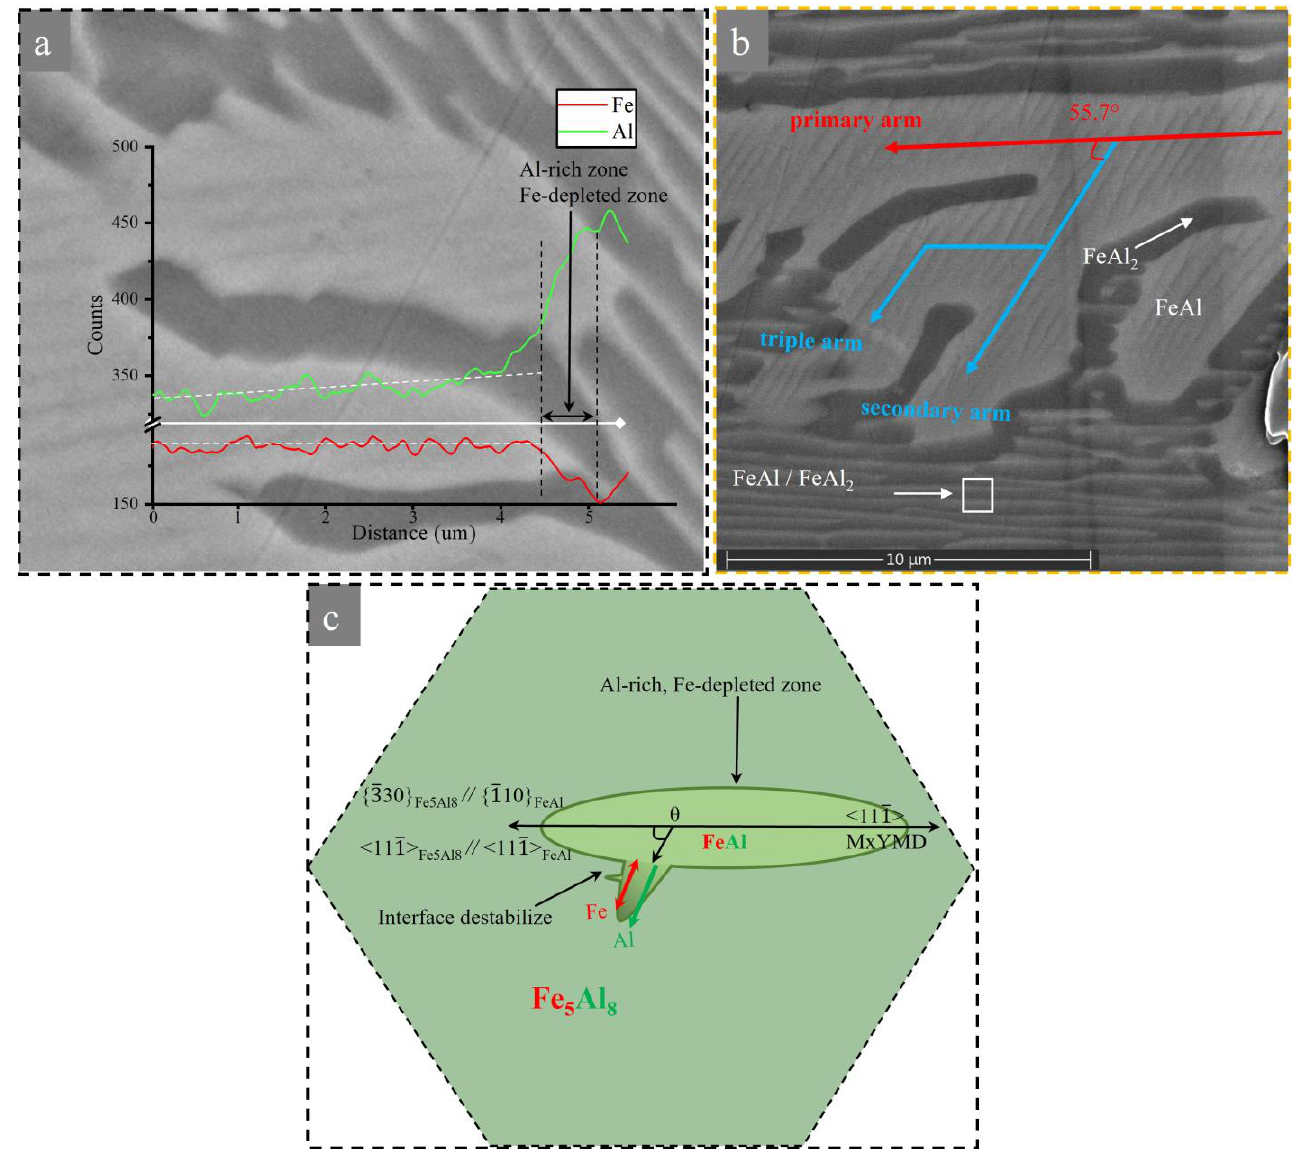
Figure 9. ( a ) SEM-EDS line scan of the secondary arm. ( b ) SEM image of the area ‘d’ in Figure 5a. ( c ) The evolution model of FeAl solid-state dendrite. ( c ) The evolution model of FeAl solid-state